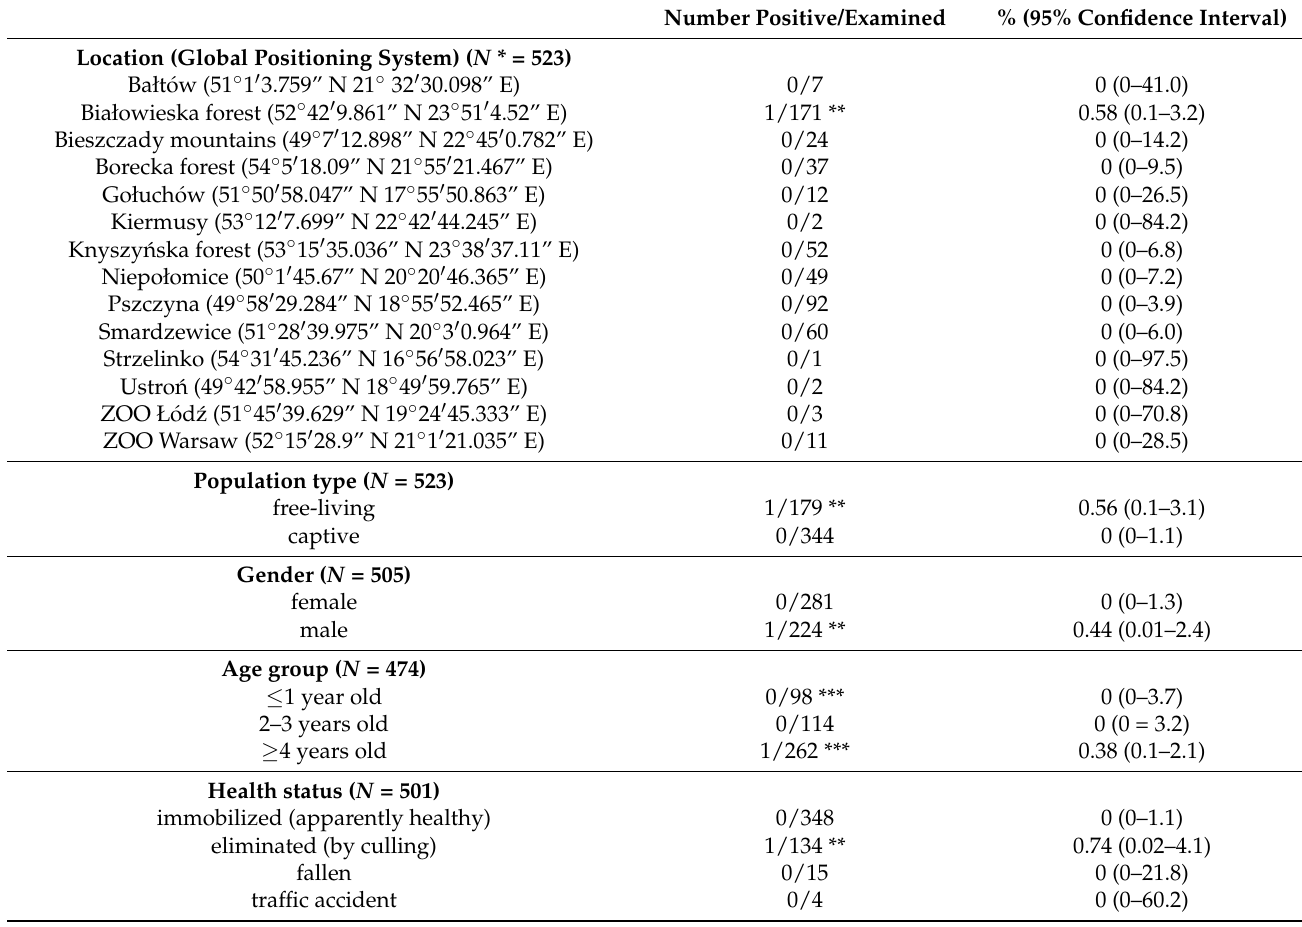
Table 1. Descriptive statistics of seropositive to Coxiella burnetii European bison ( Bison bonasus ) with regard to their different